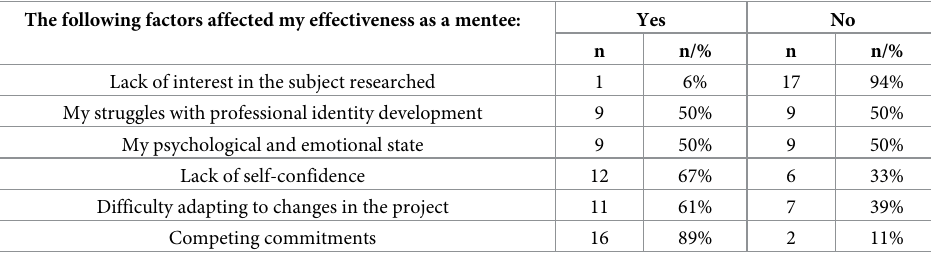
Table 9. Factors affecting effectiveness of